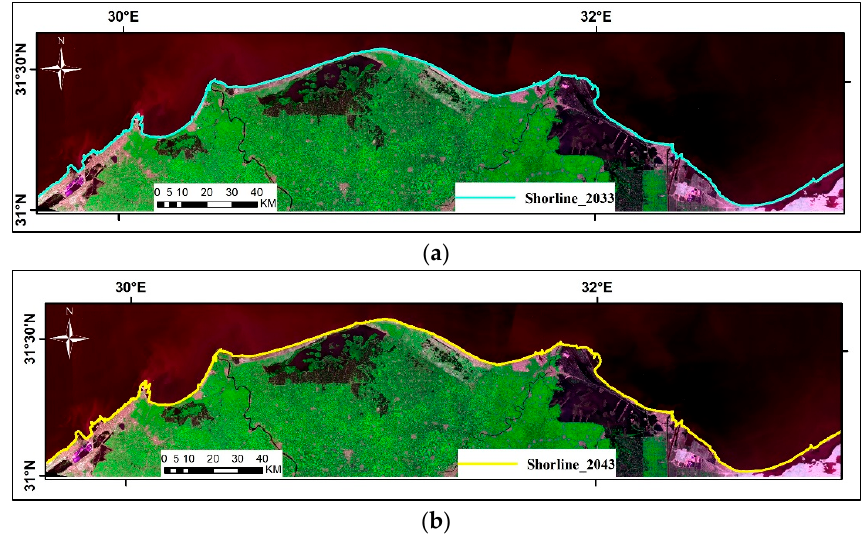
Figure 5. The predicted shoreline at the Nile Delta for the years ( a ) 2033 and ( b )